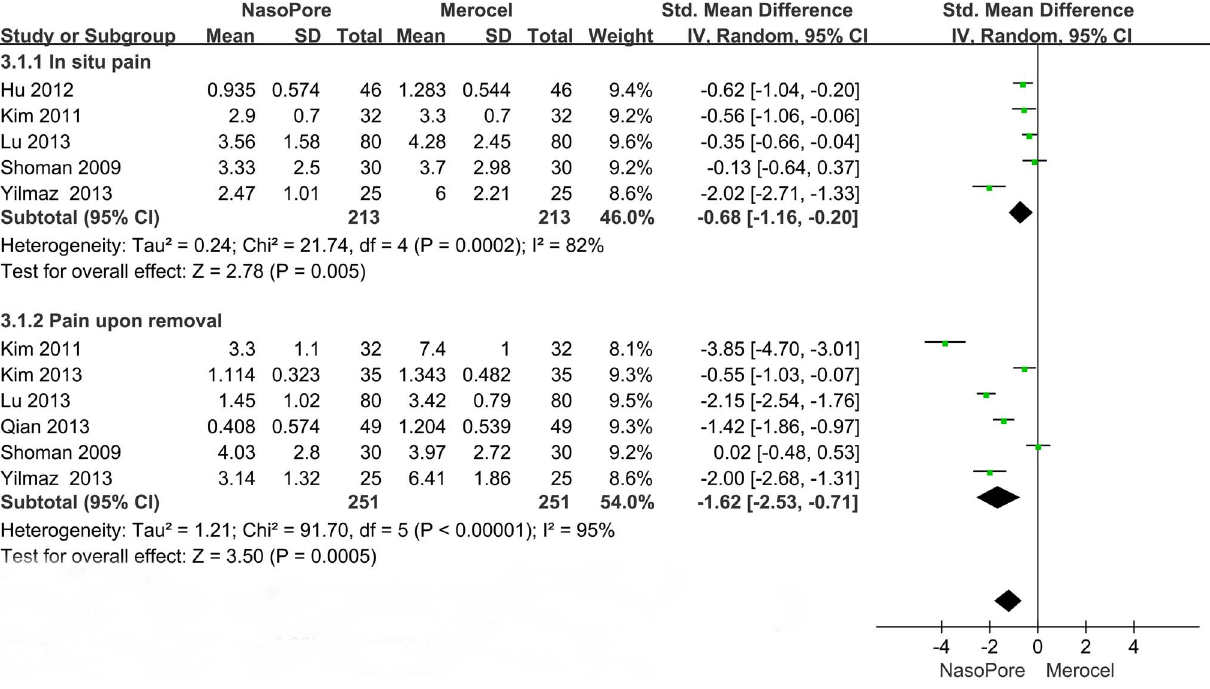
Figure 3. Forest plots of SMD and 95% CI for in situ pain and pain upon removal.